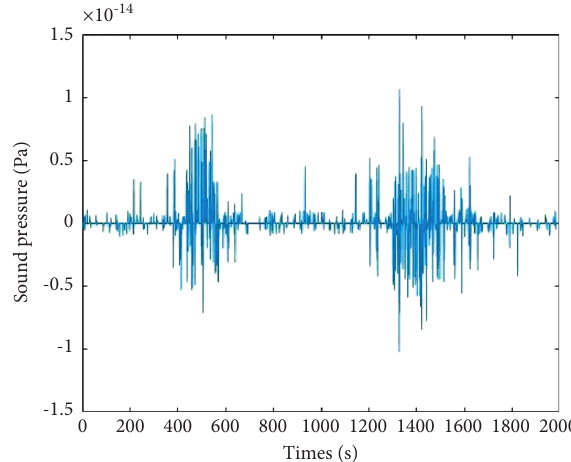
Figure 17: CEEMDAN reconstruction signal error of the simulation signal.